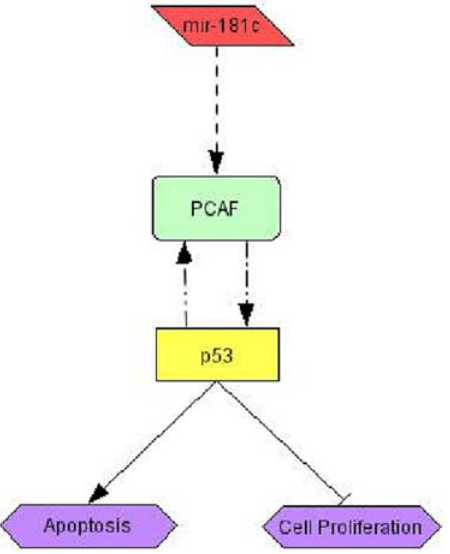
Figure 8. Tumor suppressive pathway involving miR-181c.